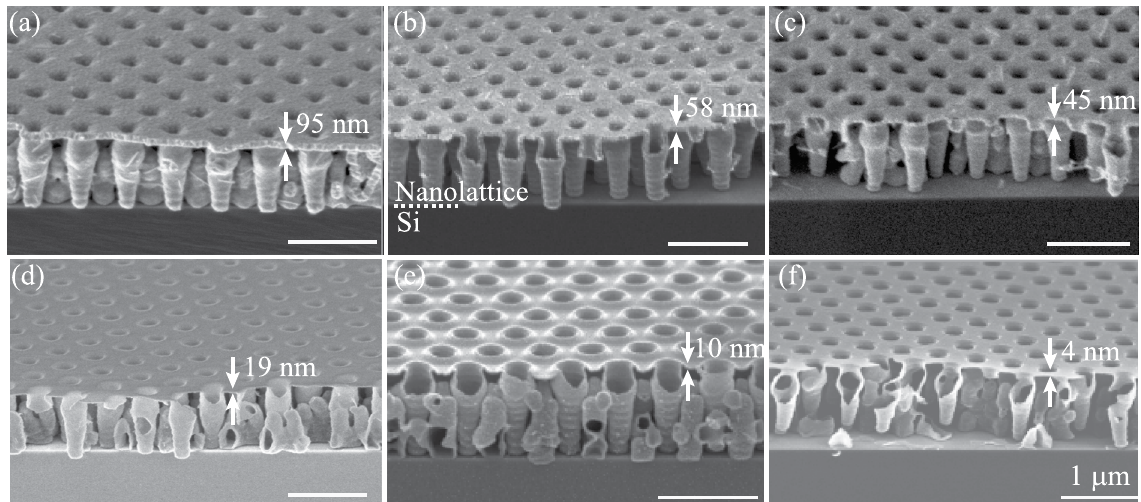
Figure 1. Scanning electron micrographs of samples used for mechanical testing. ( a–c ) Cross-sectional image of ZnO nanolattices with thicknesses 95 nm, 58 nm, and 45 nm respectively. ( d–f ) Cross-sectional SEM image of Al 2 O 3 nanolattices with thicknesses 19 nm, 10 nm, and 4 nm respectively. The thinnest nanolattice tested for mechanical properties had a shell thickness of 4 nm. Cross-sectional image of 4 nm nanolattice shows the structure is free-standing and does not collapse during template removal